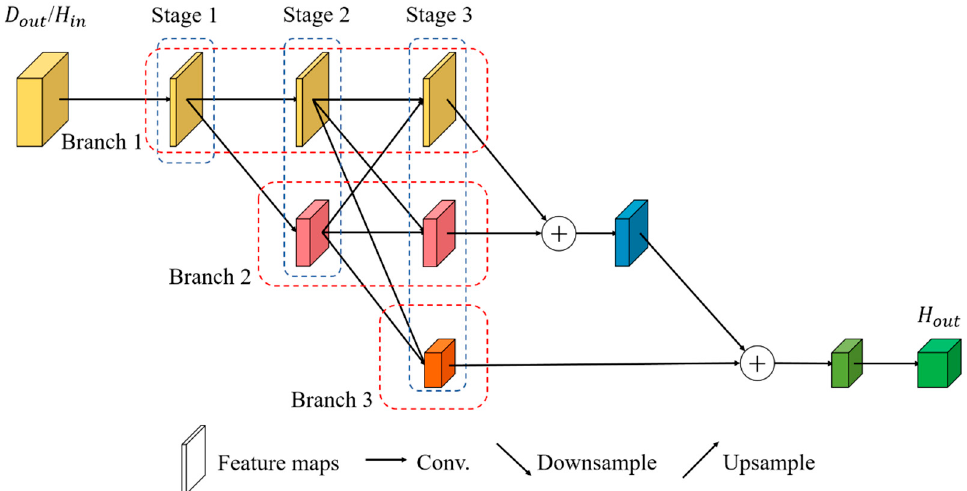
Figure 4. Hybrid Resolution